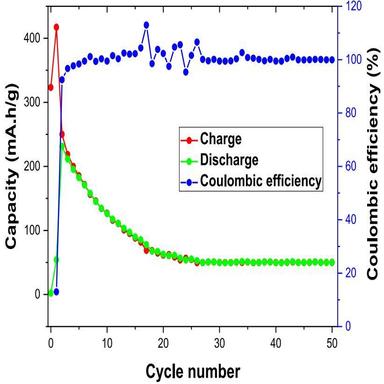
Electrochemical performance of Ni3(C8H4O4)3(C3H7NO)4: cycling performance profiles.